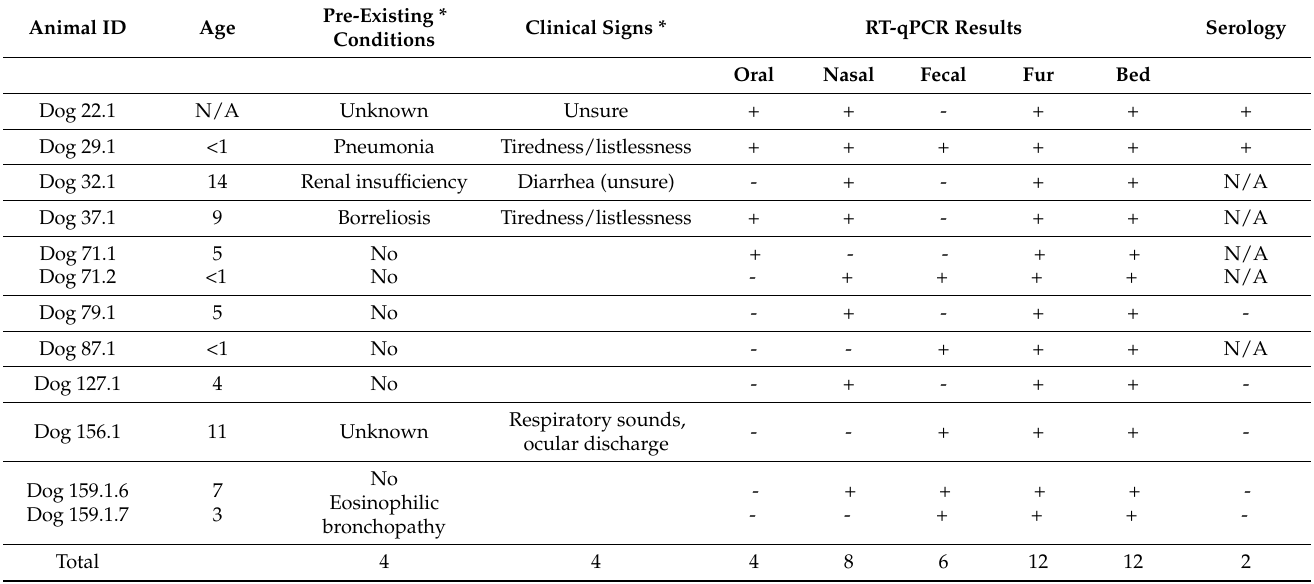
Table 2. Overview of the 12 SARS-CoV-2-positive dogs: their ages, pre-existing conditions, clinical signs, RT-qPCR results from different samples, and serology results.